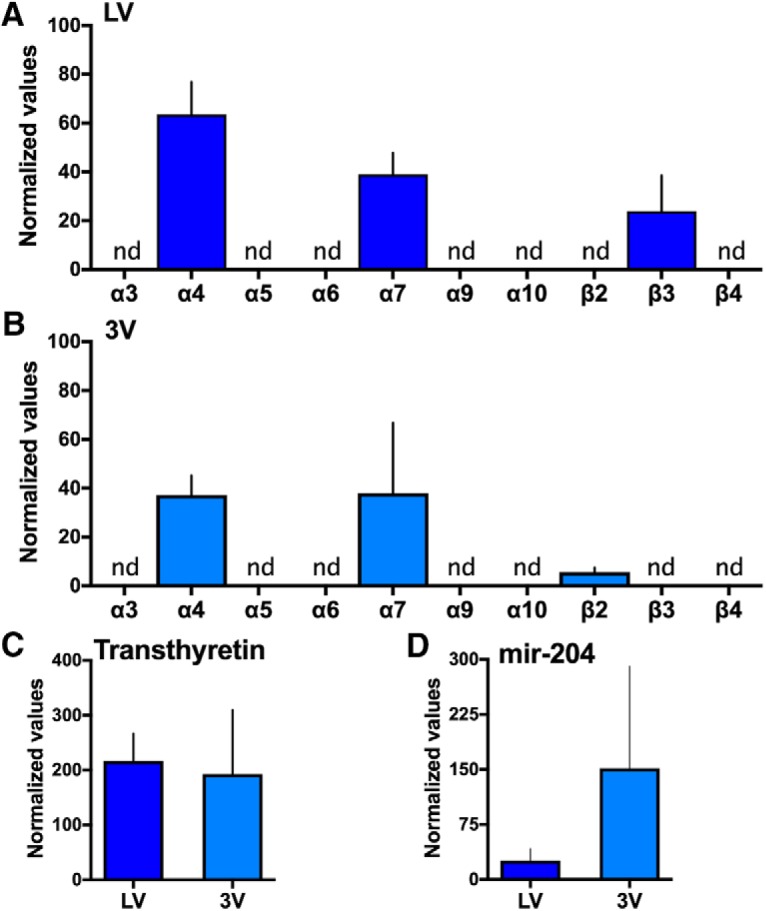
Expression of nAChR subunits, transthyretin and mir-204 in human choroid plexus tissue. Choroid plexus from the lateral and third ventricle (3V) were examined from postmortem humans (n = 3 for all analyses shown). A, In the lateral ventricle (LV), mRNA expressions of α4 (CHRNA4), α7 (CHRNA7), and β3 (CHRNB3) were detected. Statistical data are as follows Central tendency (mean) ± variation (SEM), lower 95% confidence interval, upper 95% confidence interval: α4: 63.51 ± 13.39, 5.88, 121.1; α7: 38.97 ± 8.83, 0.95, 76.98; and β3: 23.97 ± 14.55, 0, 86.56. B, In the 3V, mRNA expressions of α4 (CHRNA4), α7 (CHRNA7), and β2 (CHRNB2) were identified. Statistical data are: α4: 37.30 ± 7.90, 3.33, 71.28; α7: 38.06 ± 28.76, 0, 161.8; and β2: 5.62 ± 1.92, 0, 13.86. C, Transthyretin expression was found at similar levels in the lateral and 3V of human tissue. Statistical data (mean ± SEM, lower CI, upper CI) are: LV: 216.7 ± 50.10, 1.15, 432.3 and 3V: 192.6 ± 117.2, 0, 696.8. D, Expression of mir-204 was abundantly localized in the 3V choroid plexus, with lower levels found in the lateral ventricle tissue. Statistical data (mean ± SEM, lower CI, upper CI) are: LV: 25.91 ± 16.36, 0, 96.31 and 3V: 151.5 ± 139.1, 0, 749.9. Expression data were normalized to expression of β-actin (n = 3 for each gene/region). For all of the above, the absence of a bar above the denoted nAChR subunit indicates that the mRNA was not detected (nd) based on the predetermined RT-qPCR criteria (Ct value > 35). Data represent mean normalized values ± SEM.